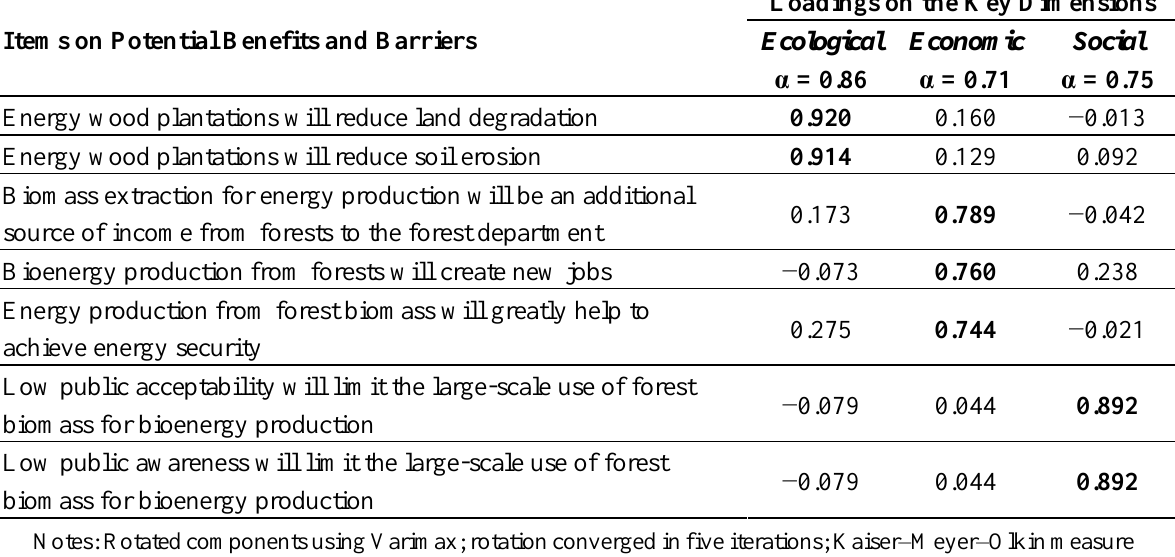
Table 3. Key dimensions of the Chinese and Indian forestry professionals’ perceptions of forest-based bioenergy projects (pooled